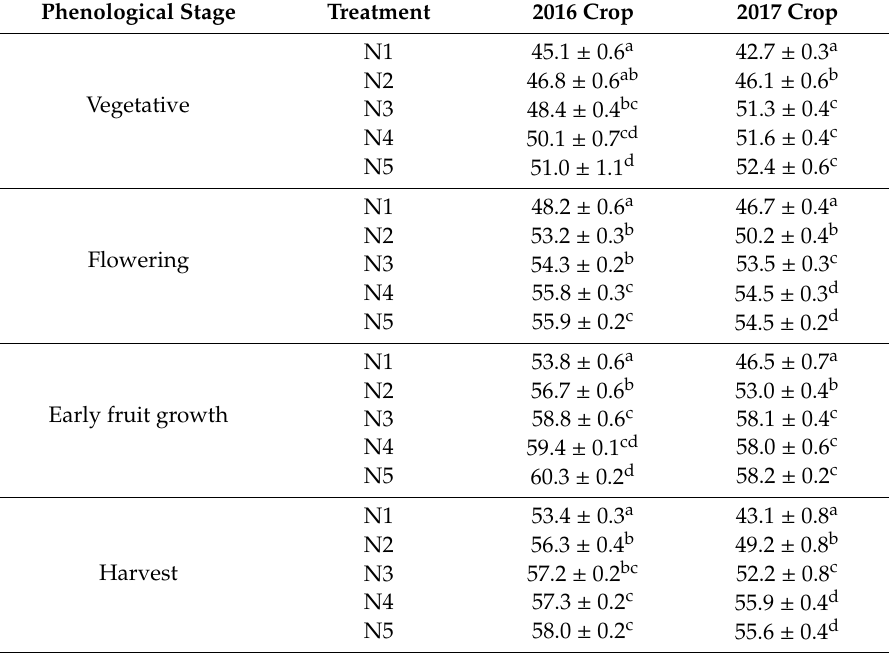
Table 4. Integrated atLEAF ( atLEAFi ) values for each N treatment within each phenological stage in the two sweet pepper ( Capsicum annuum ) crops. Di ff erent lower-case letters (a–d) show significant di ff erences between treatments within each phenological stage and crop, after LSD post-hoc test of ANOVA. p -value < 0.001. Values are means (n = 4) ± standard error (SE). Each crop was subjected to five di ff erent N treatments with four